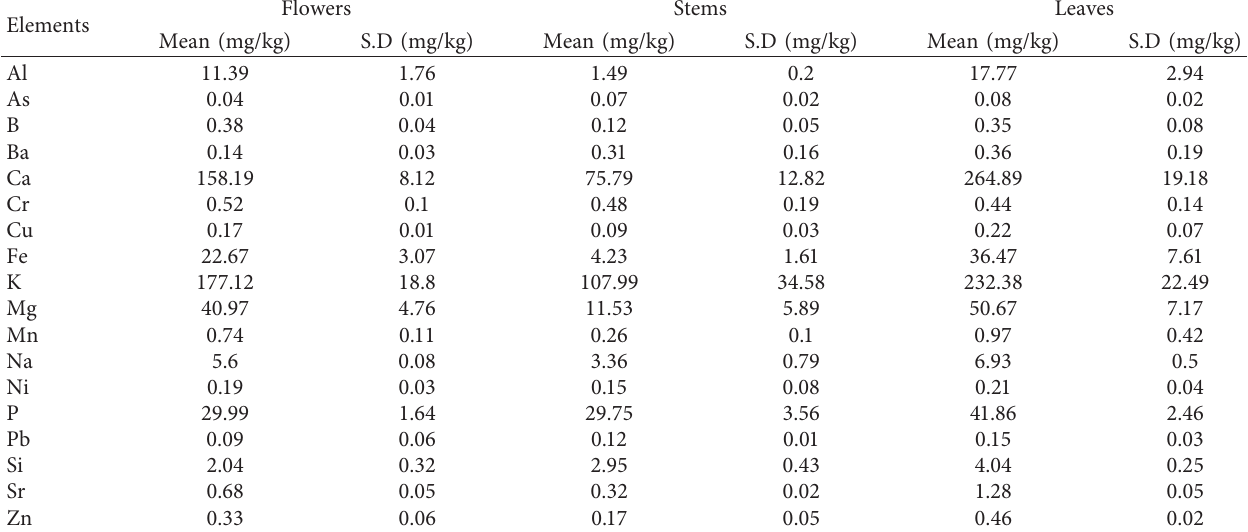
Table 1: Descriptive statistics for heavy metal content and trace elements (mg · kg − 1 ) in Origanum grosii.